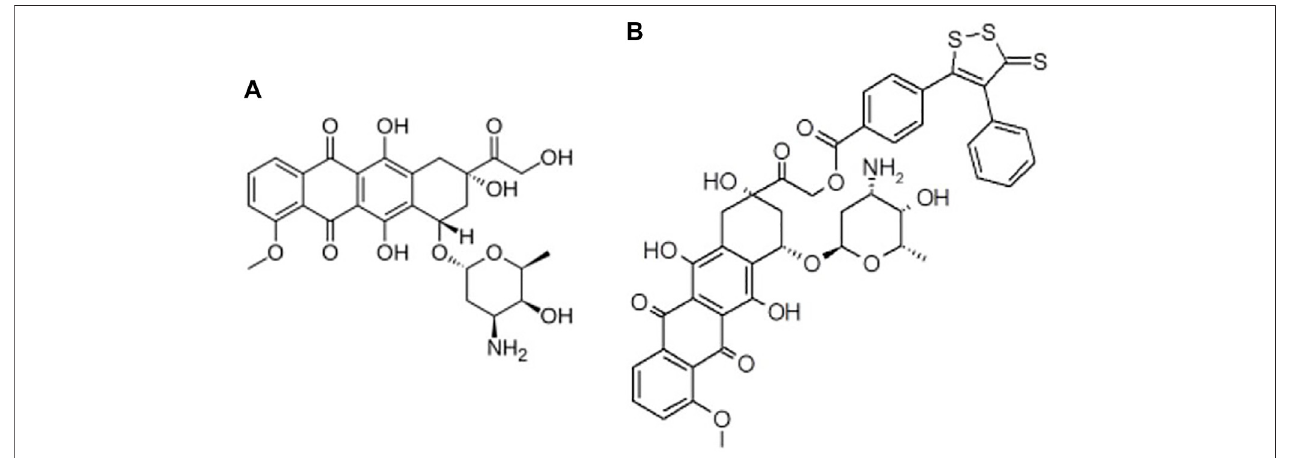
FIGURE 1 | 2D structures of (A) Dox and (B) Sdox.